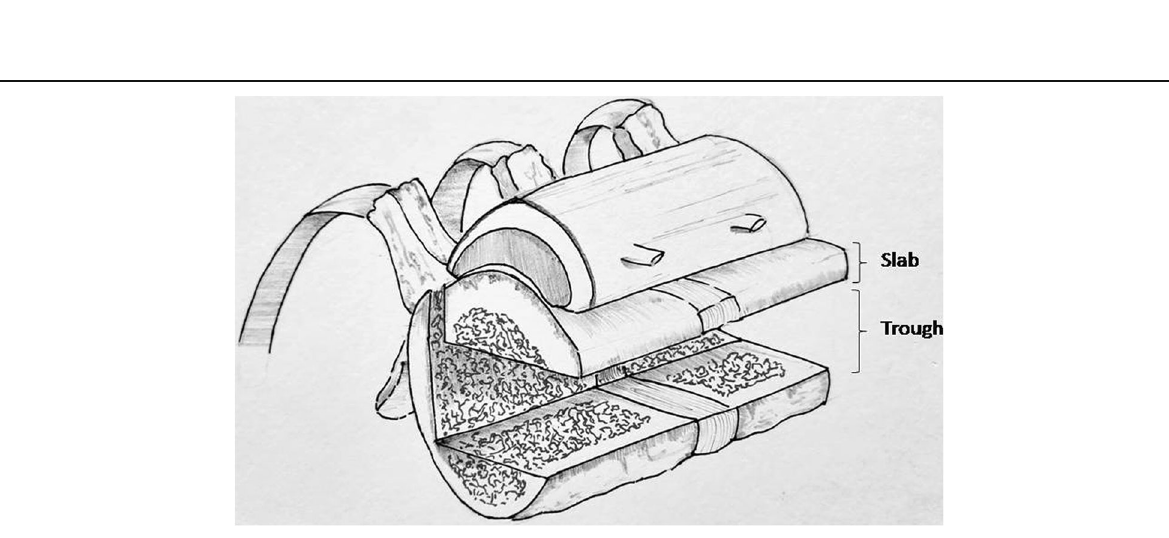
Fig. 5 Illustration showing that after the block is removed; the slab still presents ventral to the cord with